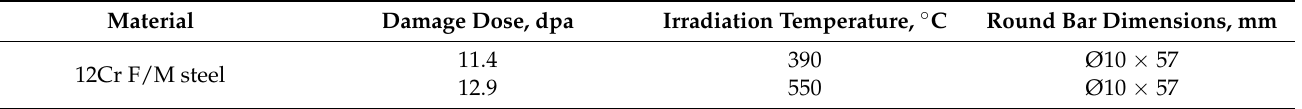
Table 2. Irradiation